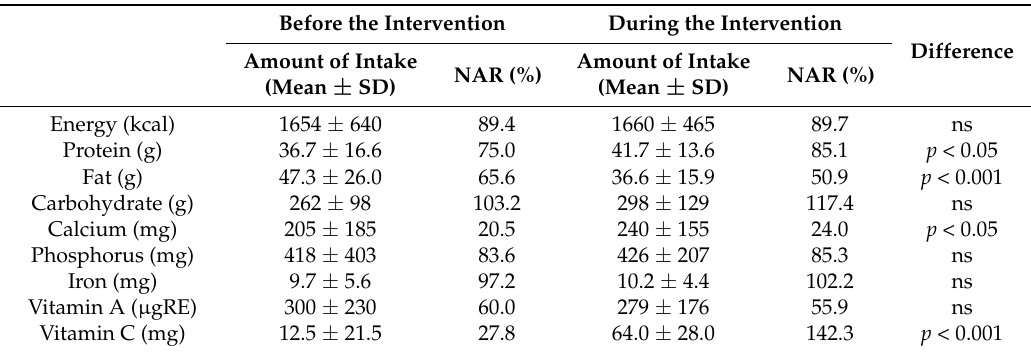
Table 3. Energy and nutrient intakes before and during the intervention by 24 h recall for food consumption ( n = 68). NAR: nutrient adequacy